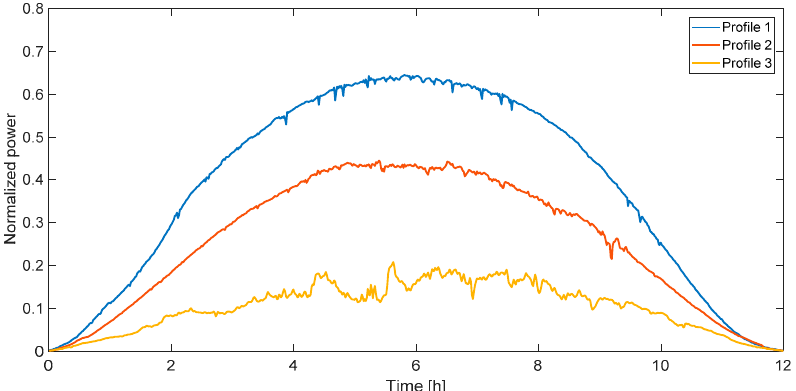
Figure 3. PV production profiles expressed in terms of normalized power and derived with the clustering procedure. Table 1. Seasonal composition of the clusters.